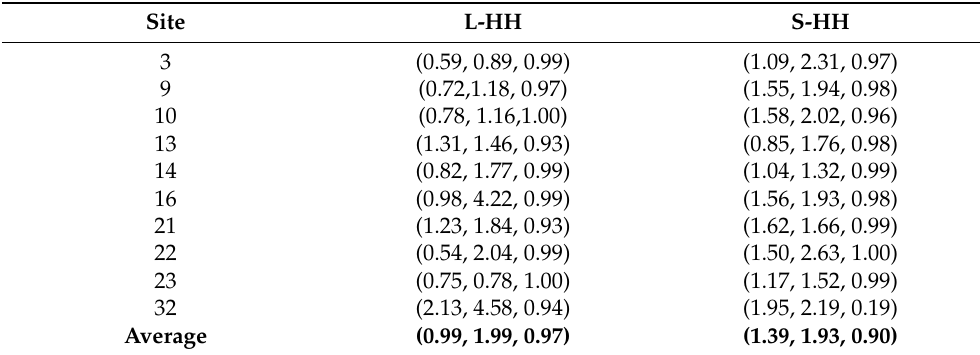
Table 4. Forward model comparison of backscattering coefficients for soybean. Within parenthesis are ubRMSE in dB, RMSE in dB, and